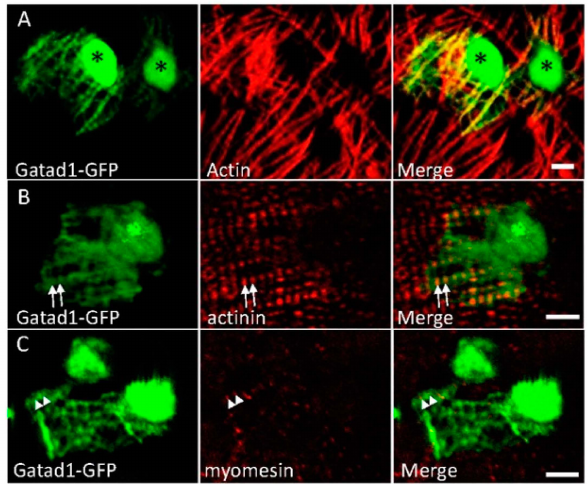
Figure 3. Subcellular localization of the Gatad1 protein in the embryonic zebrafish heart. After the myl7:gatad1-GFP construct was injected into 1-cell staged embryos, hearts from 2 dpf embryos were dissected for immunostaining and imaging. ( A ) Gatad1-GFP shows strong expression in nuclei and relatively weak expression in myofibrils, overlapping with Actin as revealed by phalloidin staining; ( B ) Gatad1-GFP partially overlaps with Z-discs marked by Actinin (arrows); ( C ) Gatad1-GFP forms alternatively striated patterns with M-line marked by Myomesin (arrowheads). * Nucleus; Scale bar 5 µ